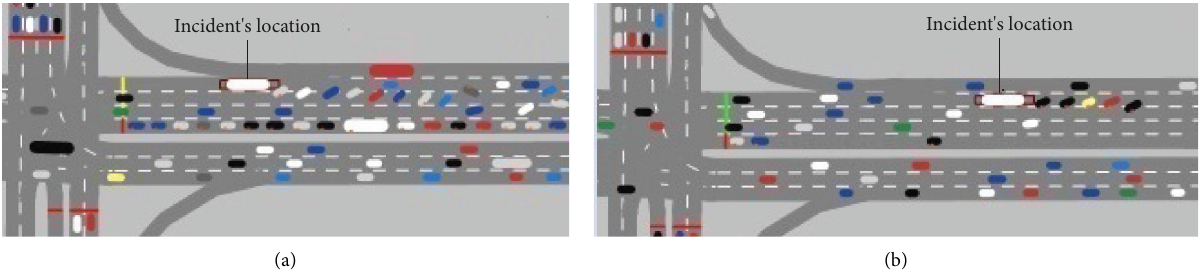
Figure 5: Vehicles’ lane-change behaviour and during an incident.